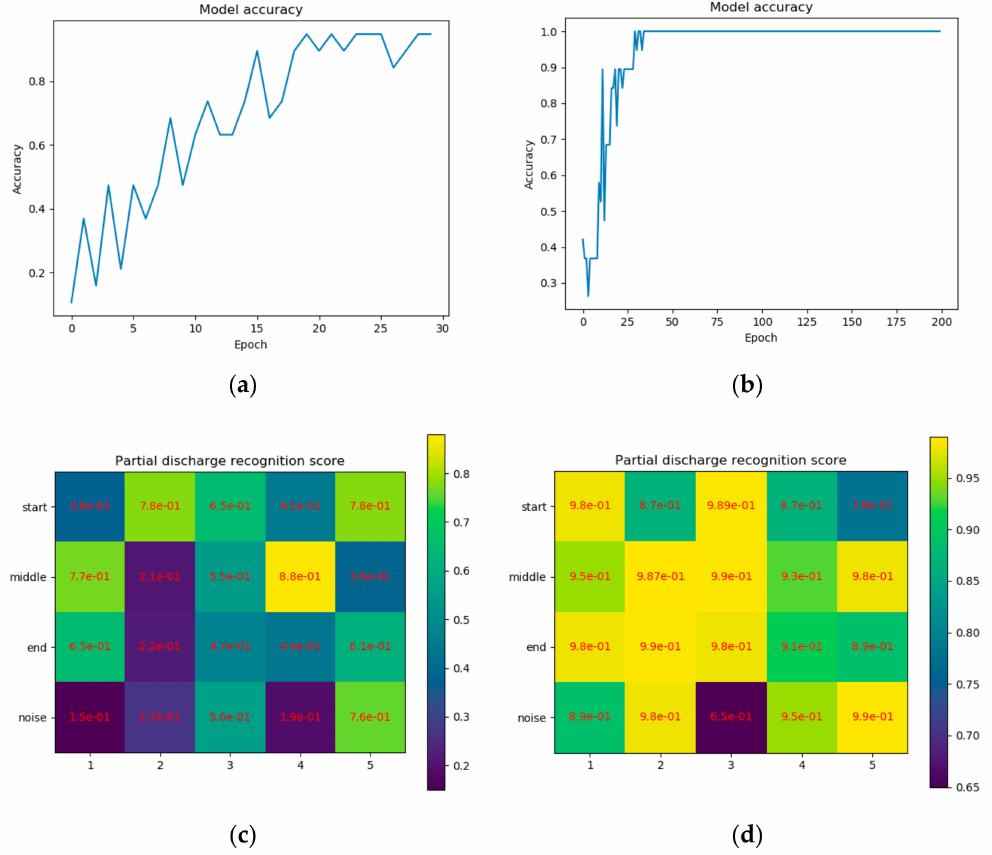
Figure 9. Exemplary recognition trial of PD monitoring stages using a convolutional neural network: ( a ) accuracy adjustment after 30 epochs; ( b ) after 200 epochs; ( c ) partial discharge recognition score after 10 epochs; ( d ) after 50 epochs. Rows in the score matrix correspond to distinguishable classes, and columns refer to the number of test